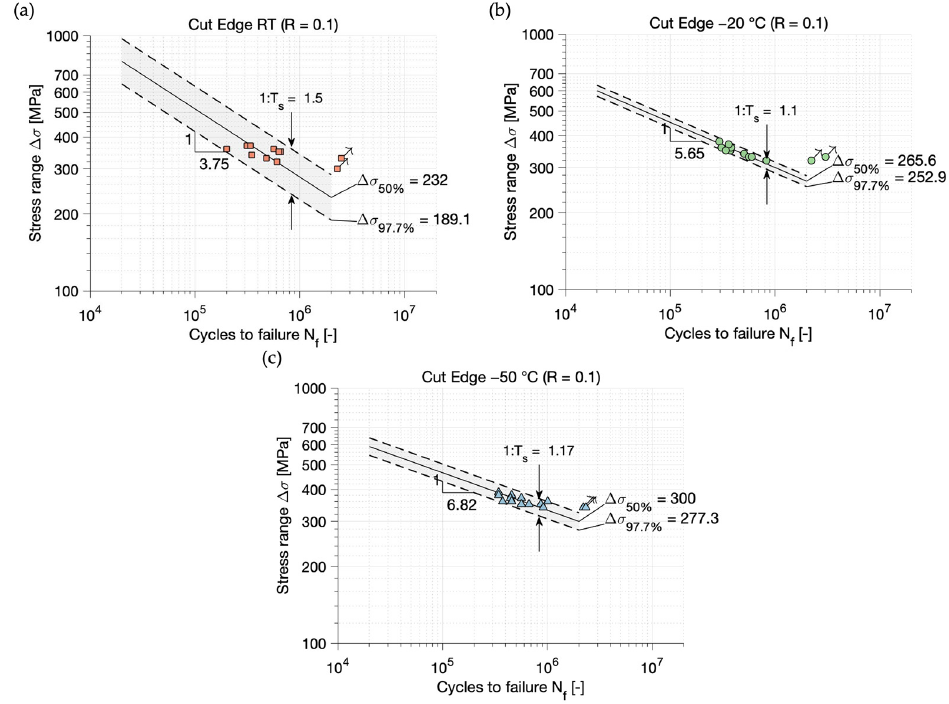
Figure 5. S-N curves of AH36 cut edges from linear regression for RT ( a ), − 20 °C ( b ) and − 50 °C ( c ).